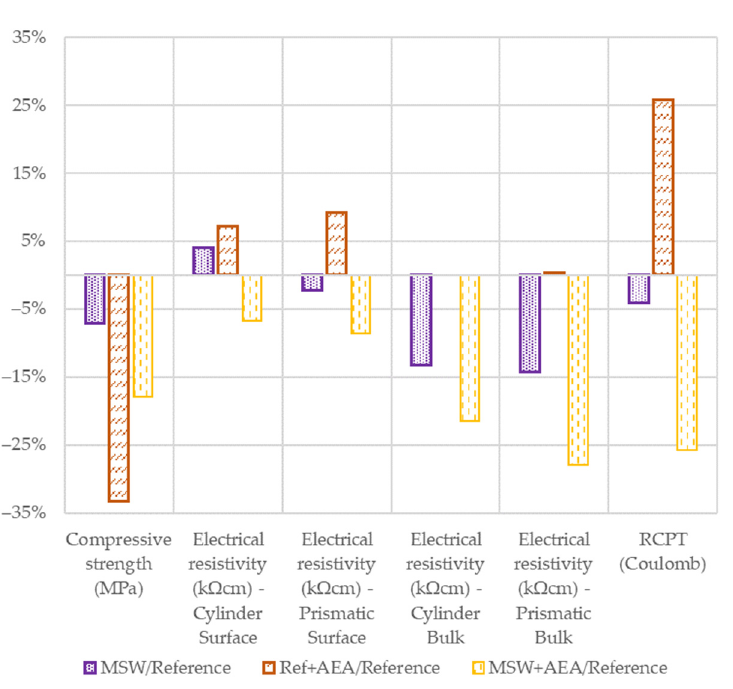
Figure 5. Relative results in 56